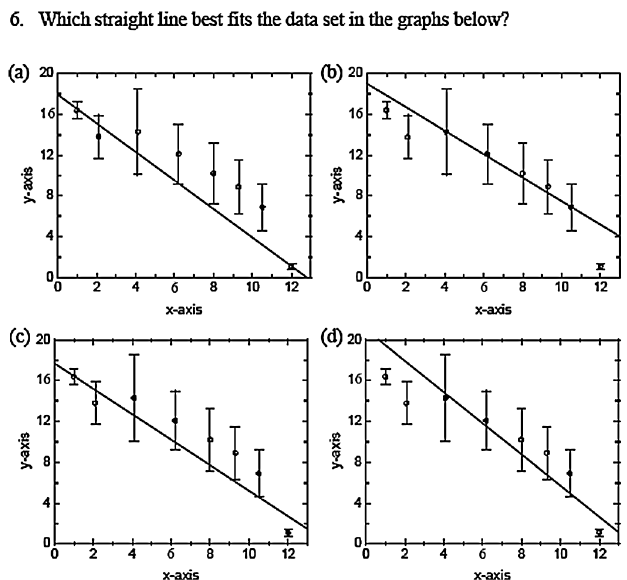
FIG. 6. Item 6 is a further test of interpretation of graphically represented uncertainty and data fitting. The distractors include (b) which appears to hit two points ‘‘exactly’’ and balances three points each above and below the line, as well as coming very close to four prominent points arranged close to a straight line, (c) which touches the maximum number of data points as possible within their error bars, and, (d) which possesses an equal number of data points above and below the line. A chi-square statistic of the numerical data clearly shows that fit (a) is best. It is possible that students select the correct answer to this question for the wrong reason, i.e., because they believe a line of best fit should pass through the first and last data points in a data set (what the University of Cape Town group would likely classify as ‘‘point reasoning’’); however, we have not encountered any evidence with our students that those (very few) who select the correct answer for this question are doing it for incorrect reasons. To eliminate this weakness, a next iteration of this question should make the second to last point have the extremal minimum